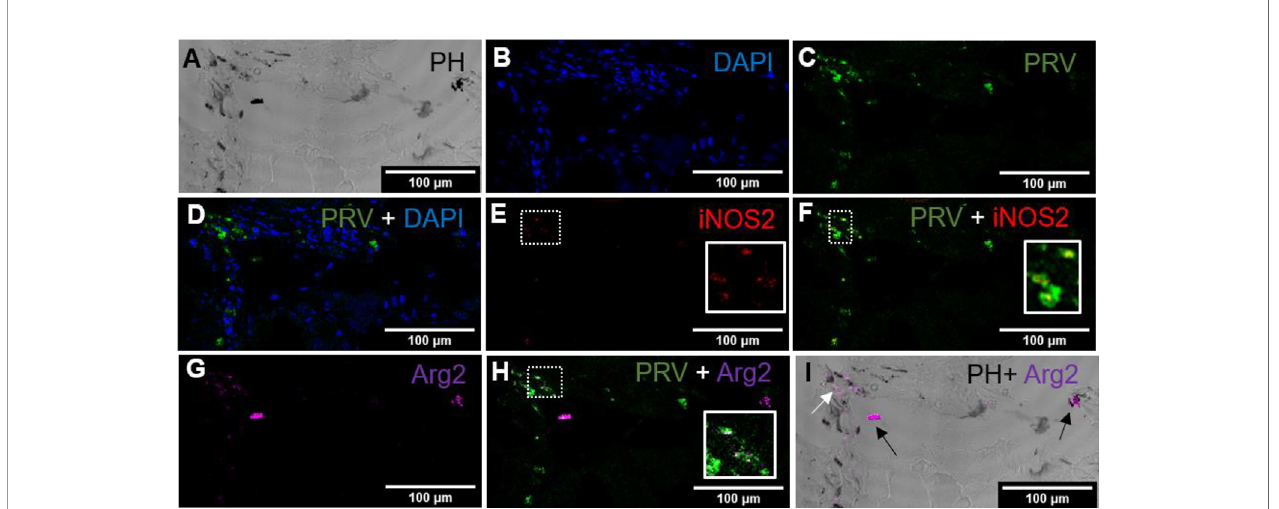
FIGURE 5 | Fluorescent in situ hybridization of PRV-1, iNOS2 and Arg2 in black focal changes (late phase). (A) Phase contrast image presence of melanin in the infected area. (B) Nuclei DNA stained with DAPI (blue). (C) PRV-1 (green) detected in severe melanized area (D) Merged PRV-1 and DAPI. Number of PRV-1 positive cells compared to total number of cells were low. (E) Few iNOS2 (red) positive cells detected at the infected area (F) Merged image showing co-localization (yellow in inset) of PRV-1 and iNOS2. (G) Presence of Arg2 (purple) positive cells. (H) Co-localization of PRV-1 and Arg2 positive cells (white in inset). (I) Localization of Arg2 speci fi c transcripts in melanized M2 melano-macrophages (black arrows) and non-melanized M2 macrophages (white arrow). Scale bar =